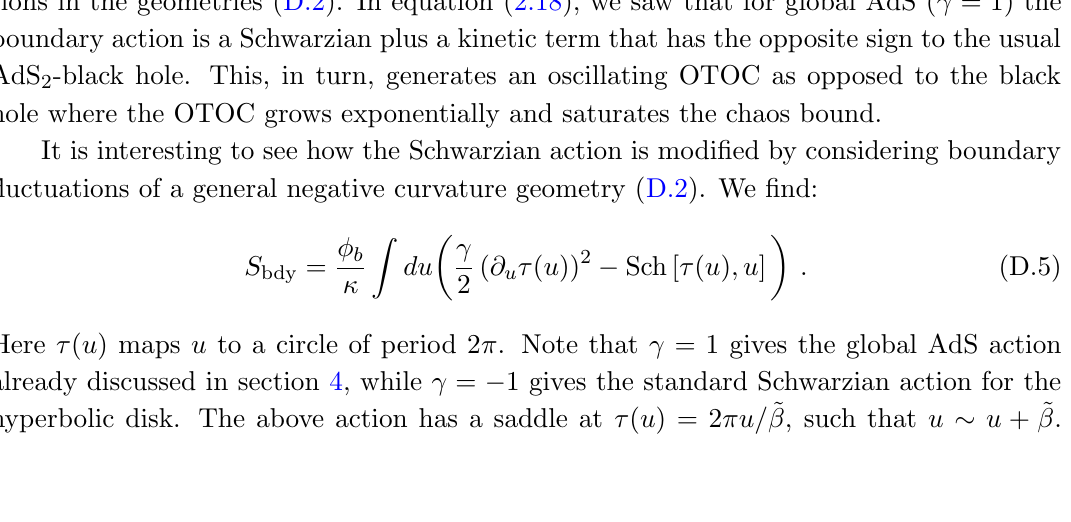
Figure 8 . A sketch of the interpolating geometry close to (cid:13) ! 0 + with (cid:30) 0 > 0. As (cid:13) approaches to zero, the interpolating geometry develops an in(cid:12)nitely large throat until it gets disconnected for (cid:13) >